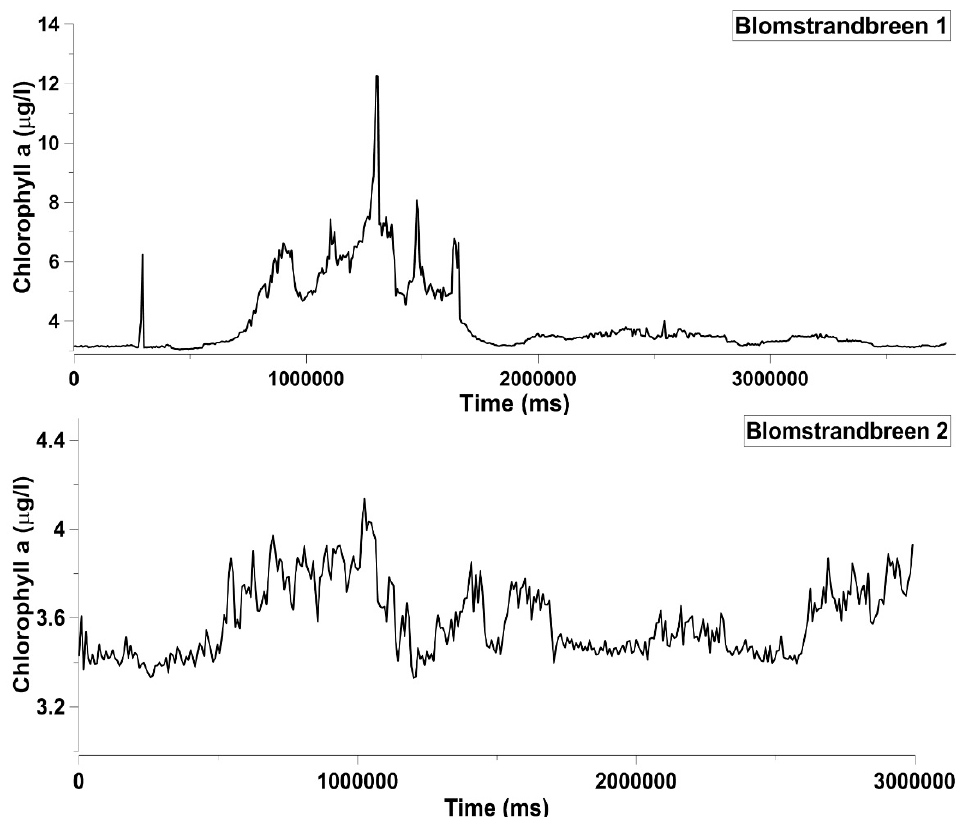
Figure 8. Chlorophyll a trend acquired by ArLoC along Blomstrandbreen 1 and Blomstrandbreen 2 transects.